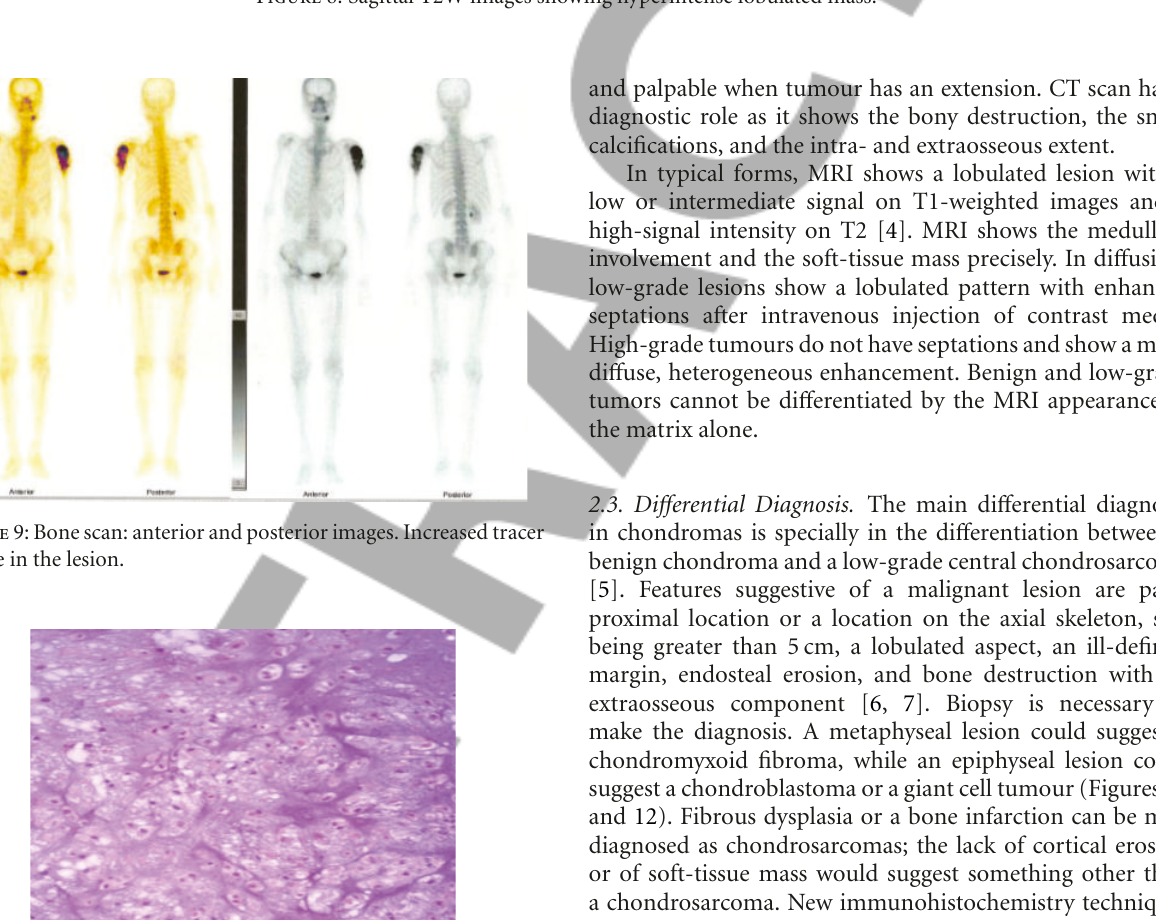
Figure 8: Sagittal T2W images showing hyperintense lobulated mass.